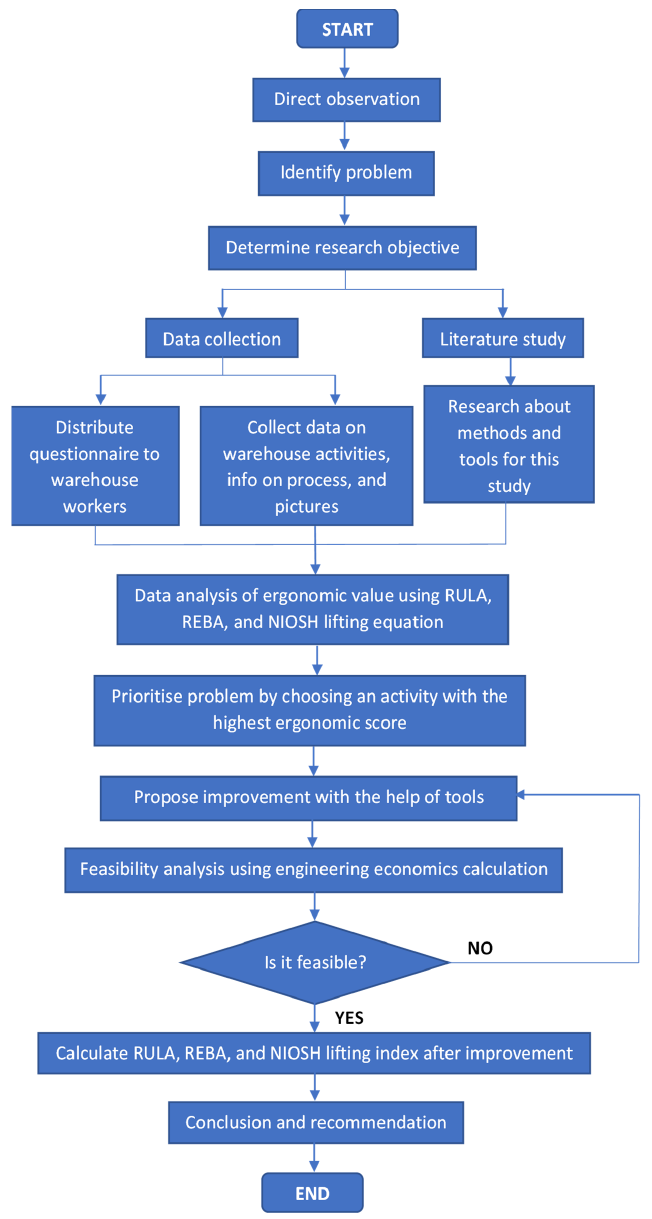
Figure 1. Research framework.